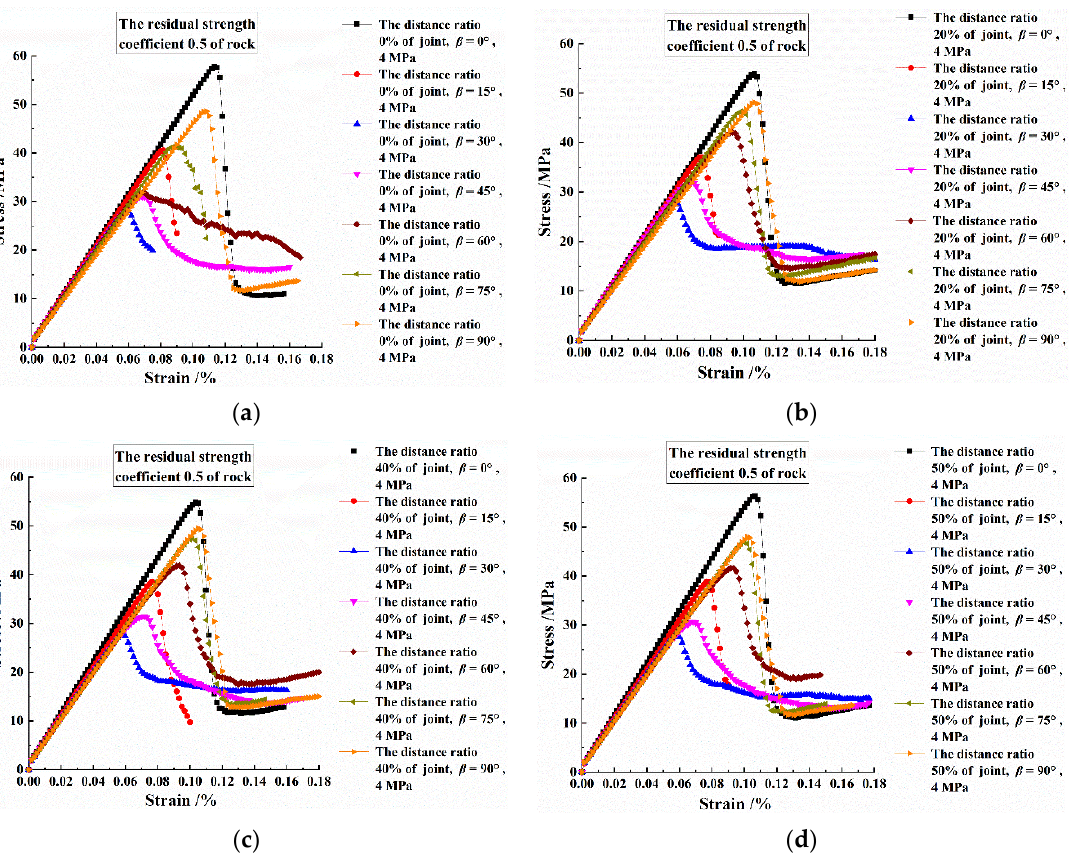
Figure 5. The loading curves of CJBs: ( a ) the joint distance ratio of 0%; ( b ) the joint distance ratio of 20%; ( c ) the joint distance ratio of 40%; ( d ) for the joint distance ratio of 50%.